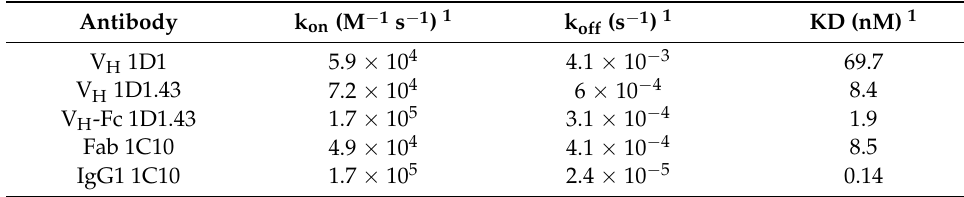
Figure 1. Binding and aggregation characterization of different format anti-hNE antibodies. ( a ) V H 1D1.43, Fab 1C10, V H -Fc 1D1.43, and IgG1 1C10 binding to recombinant NE measured by ELISA. Experiments were performed in duplicate. ( b ) Aggregation evaluation of V H 1D1, V H 1D1.43, and V H -Fc 1D1.43 measured by SEC. ( c ) Aggregation evaluation of Fab 1C10 and IgG1 measured by SEC. ( d ) Aggregation evaluation of V H and Fab measured by DLS. Antibodies were evaluated at a concentration of 1 mg/mL. ( e , f ) Kinetics of V H -Fc 1D1.43 ( e ) and IgG1 1C10 ( f ) binding to recombinant NE measured by BLItz. Values were reported as the mean ± SD. Table 1. Blitz results of human neutrophil elastase antibodies.